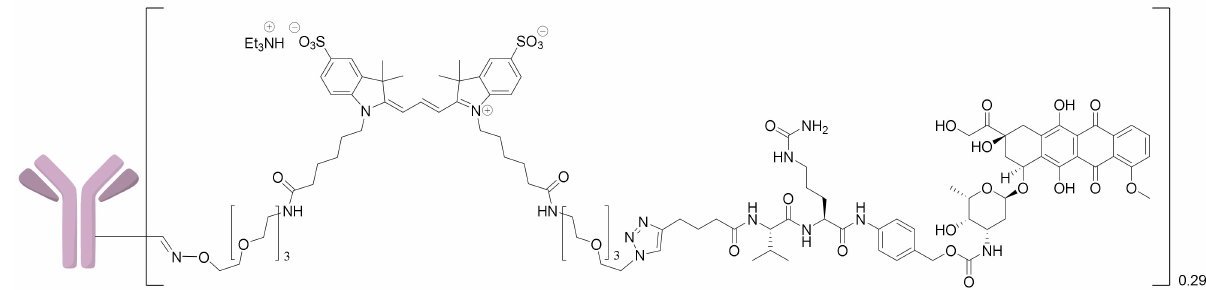
Figure 13. The structure of conjugate 3 . Conjugate 32